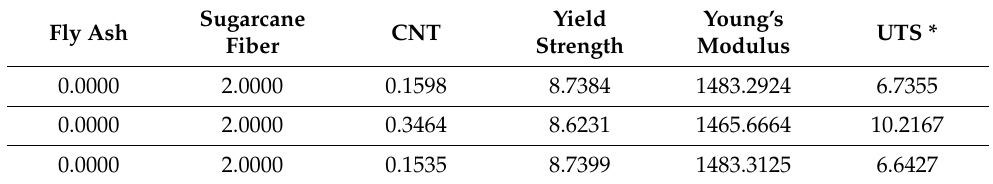
Table 5. Optimizing the objectives {YS, YM} without constraints imposed on input parameters. Fly